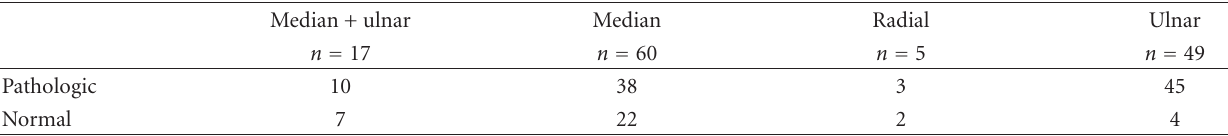
Table 2: Neurophysiological findings of the examined patients ( n =